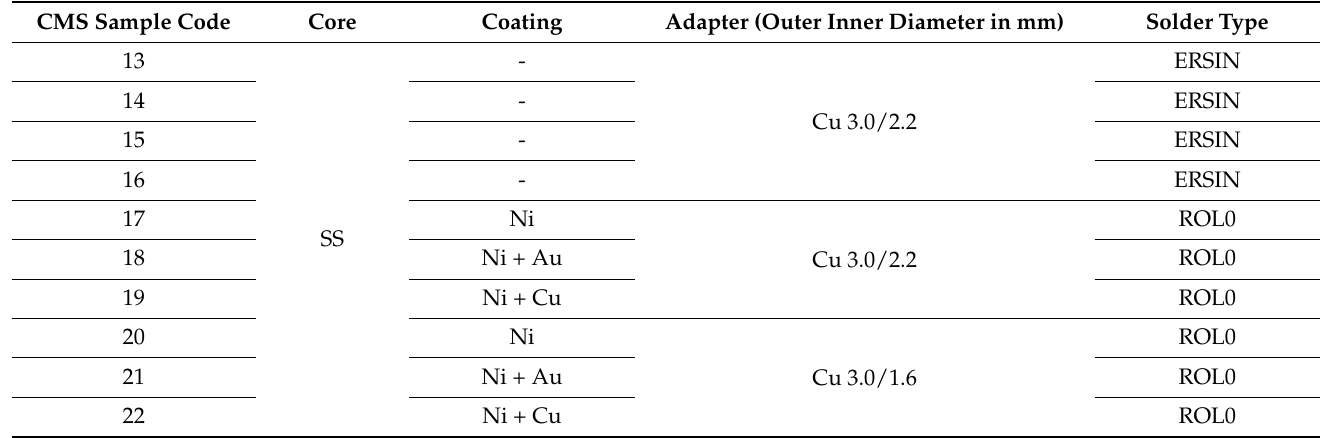
Table 4. Details of joint